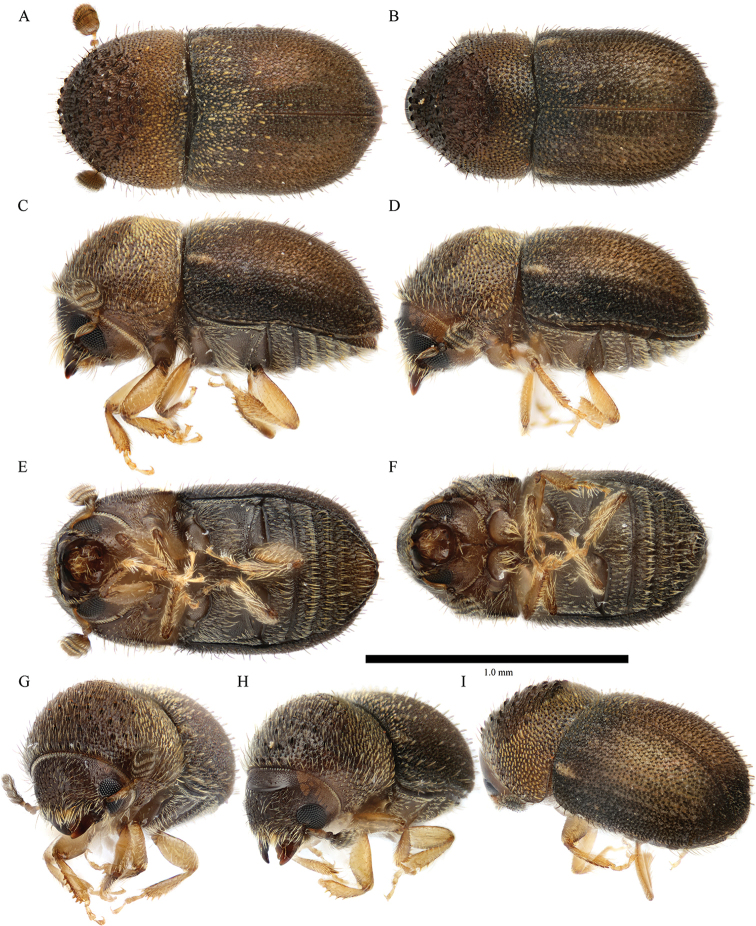
Cryphalus
artocarpusA, C, E, G female, UFFE:33166 B, D, F male, UFFE:33167 H, I male, UFFE:33165.